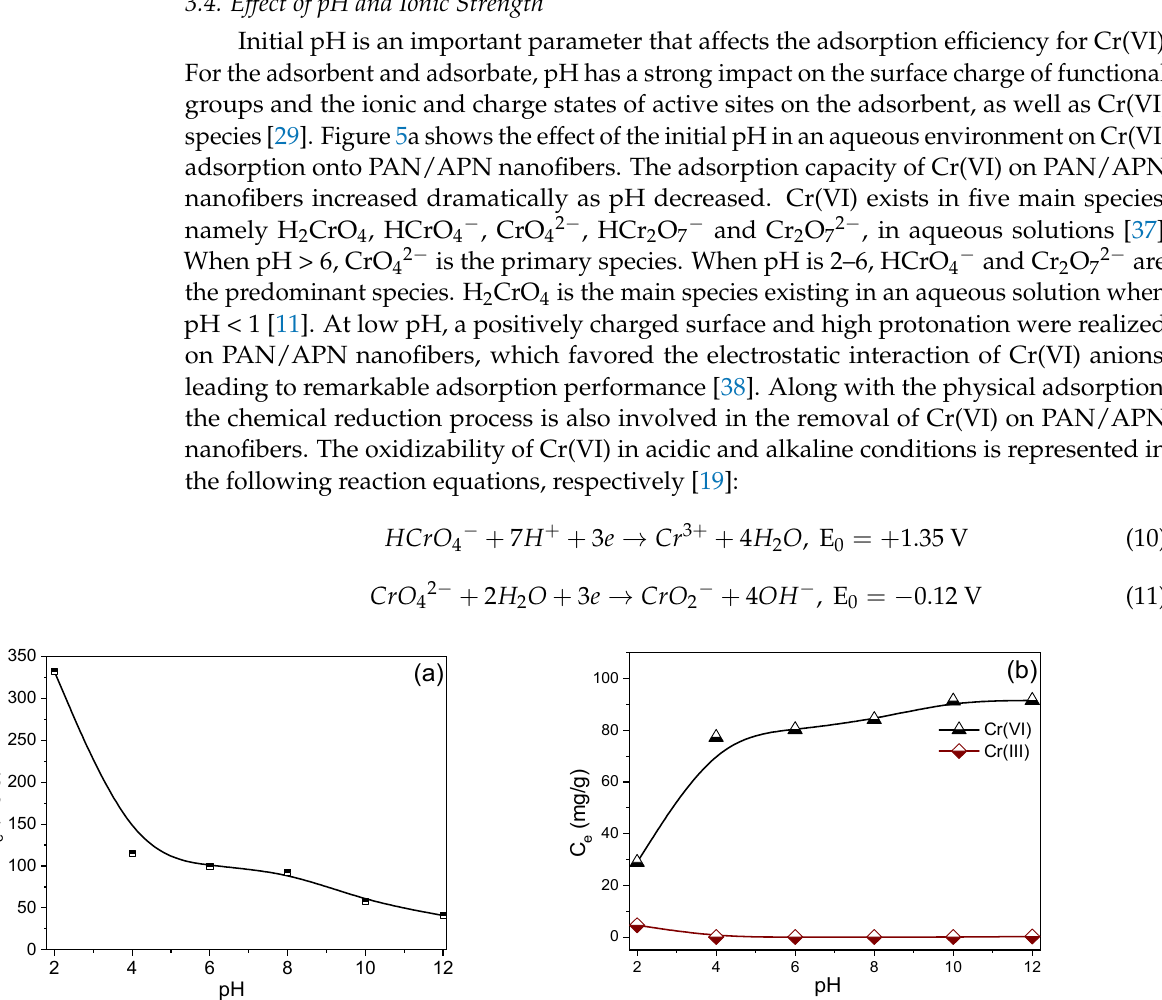
Figure 5. Effect of pH on Cr(VI) adsorption onto PAN/APNs ( a ); concentration of Cr(VI) and Cr(III) after adsorption on PAN/APNs ( b ) (T = 298 K, adsorbent dose = 0.2 g/L, C 0 = 100